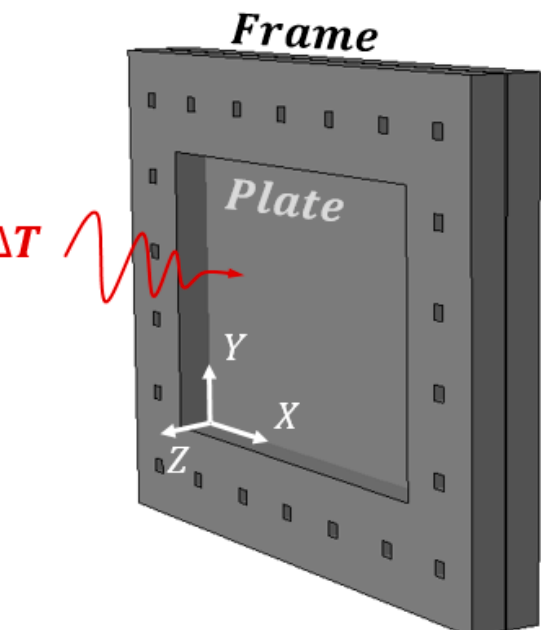
Figure 1. Plate geometry, boundary conditions and heating load.